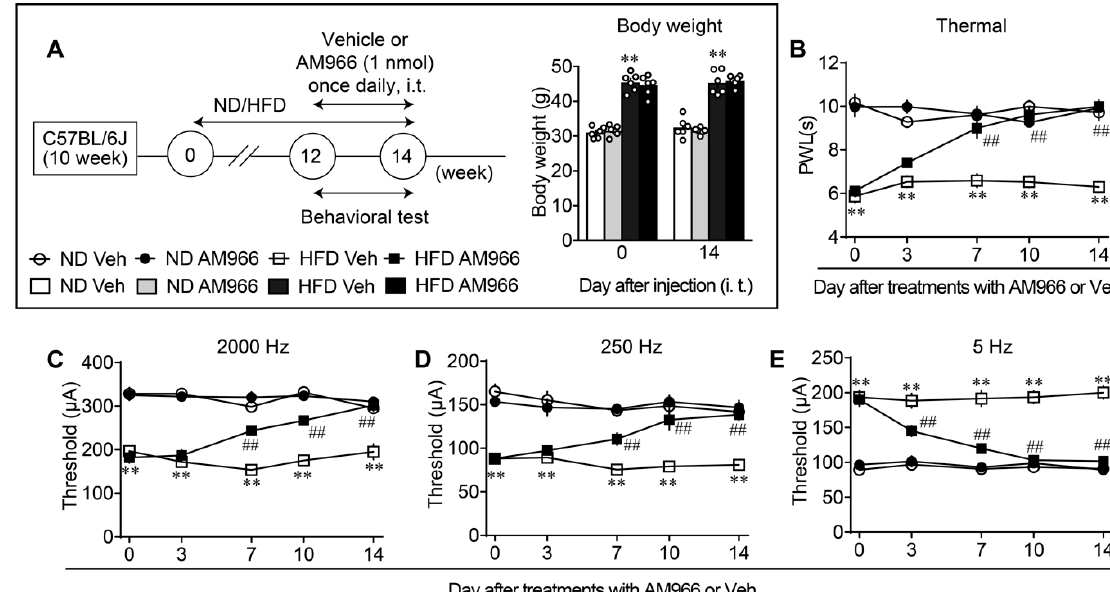
Figure 4. Complete reversal of abnormal pain behaviors in HFD model by intrathecal LPA 1 / 3 antagonist. ( A ) Experimental schedule and lack of effects on the body weight by repeated treatments with AM966. ( B – E ) Time dependent reversal of nociceptive thresholds by AM966 treatments. Results represent the threshold of paw withdrawal latency (PWL; s) in the thermal test ( B ), and currents ( μ A) in the Electrical Stimulation-Induced Paw Withdrawal (EPW) test using 2000 ( C ), 250 ( D ) and 5 Hz ( E ). ** p < 0.01, vs. normal diet (ND) vehicle (Veh), ## p < 0.01, vs. high fat diet (HFD) Veh, three-way ANOVA followed by Tukey’s multiple comparisons test ( n = 6).